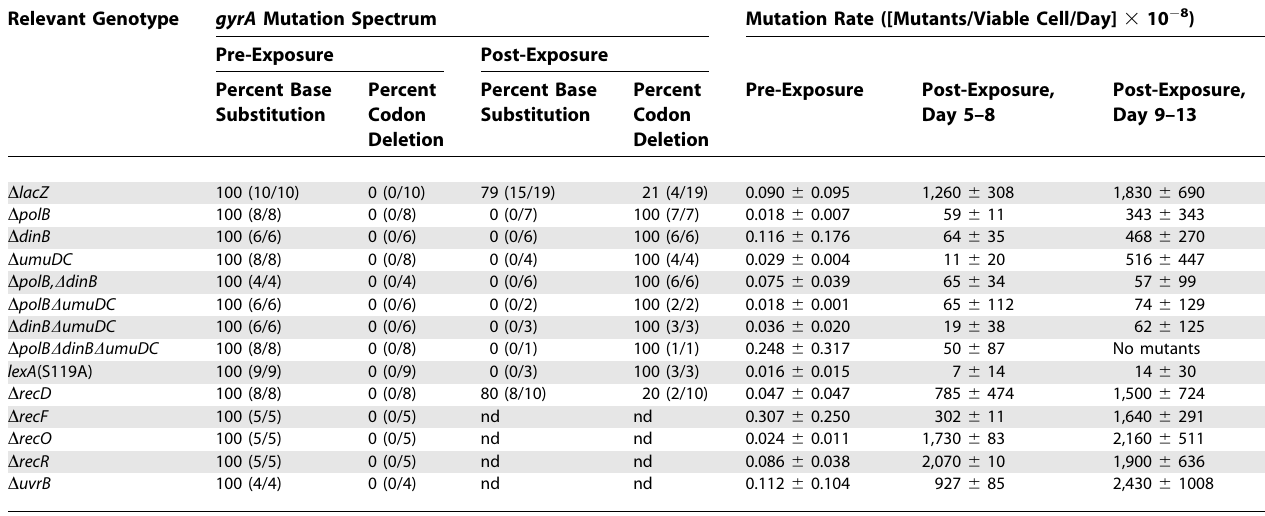
Table 3. Mutation Spectra and Rates Relevant Genotype gyrA Mutation